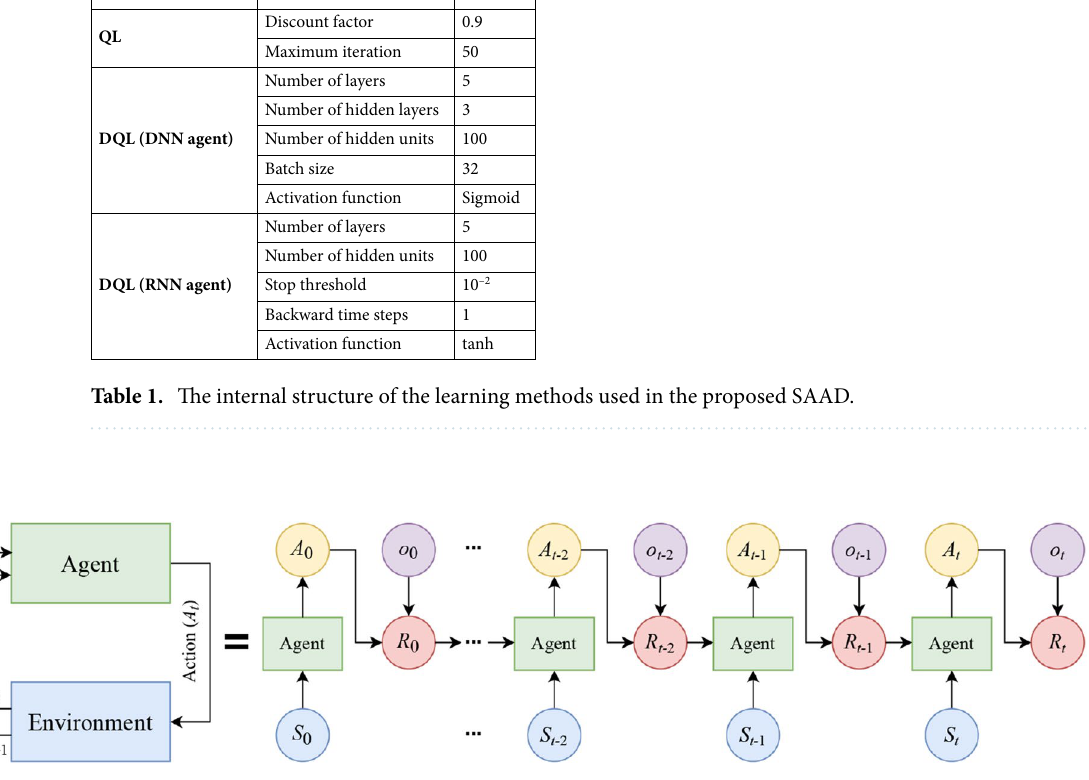
Figure 3. The block diagram of MDP in rolled (left) and unrolled (right) configurations. The agent and the environment interact over a sequence of discrete-time steps. At each time step, the agent receives a representation of the state S t of the environment and a reward R t − 1 from the previous interaction to issue an action A t